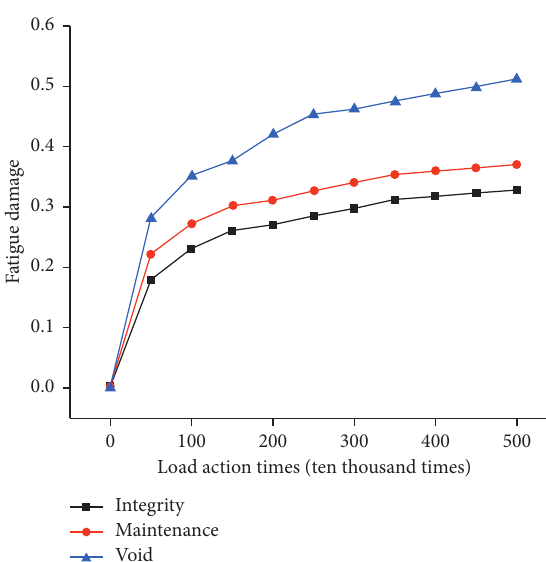
Figure 22: Cumulative evolution of fatigue damage under three working conditions under 1.4MPa tire